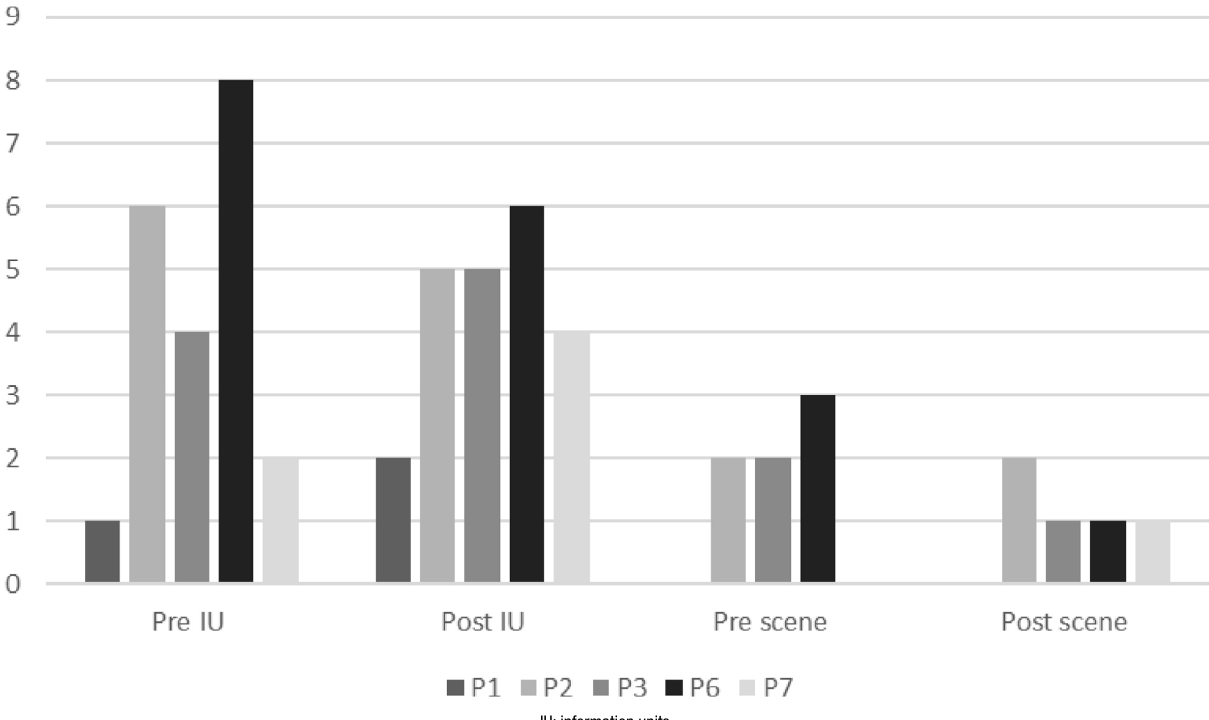
Table 2. Performance in the Montreal Cognitive Assessment test tasks for assessment and reassessment.